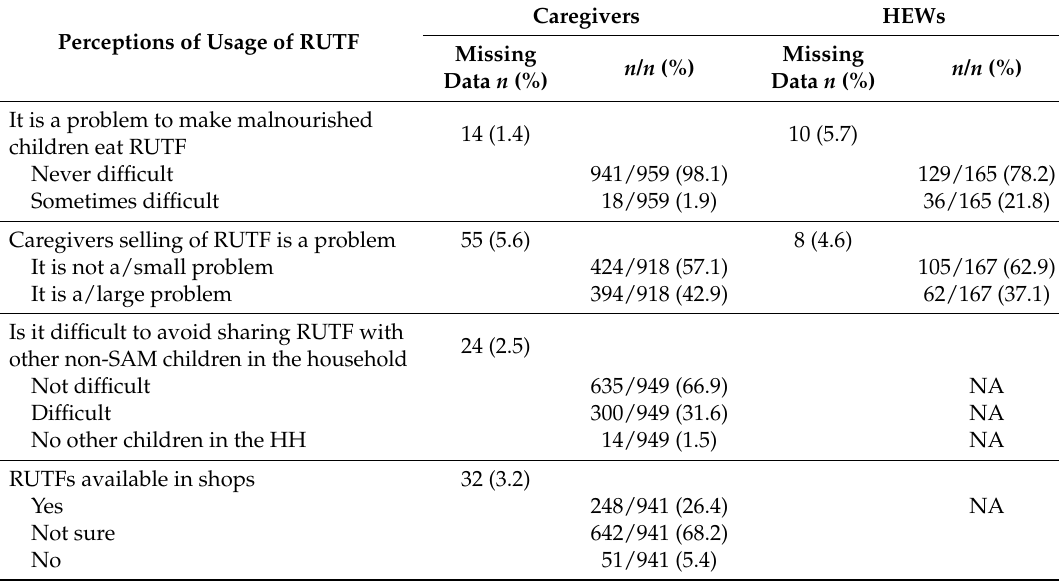
Table 2. Perceptions of Ready to Use Therapeutic Food (RUTF) usage among caregivers of